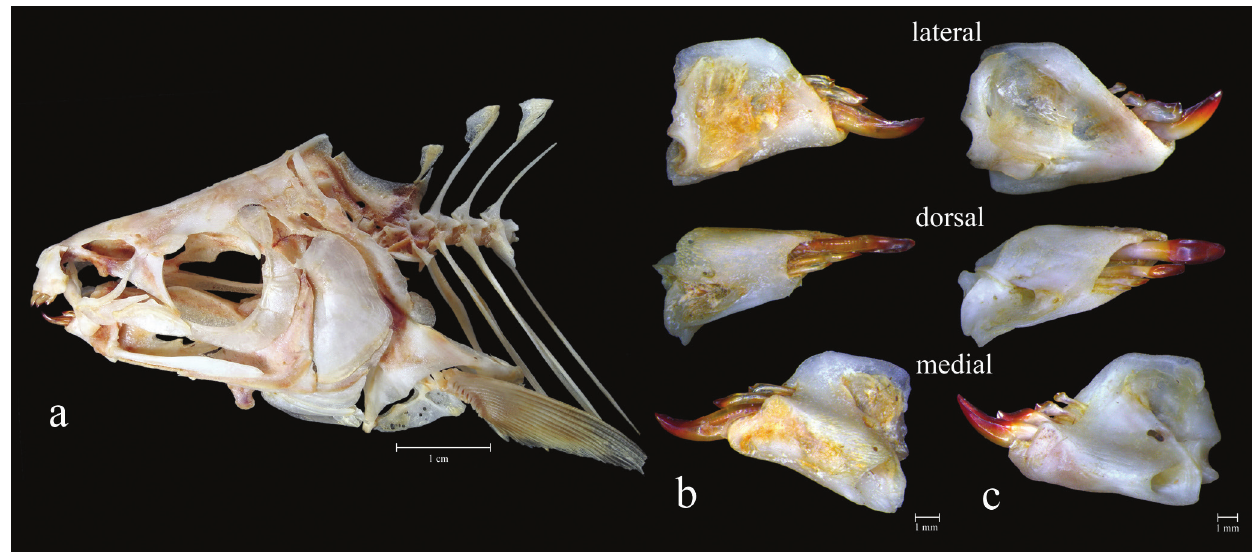
Fig. 1. (a) Head in lateral view and (b) lower jaw of Leporinus enyae , MZUEL 17001, 169.0 mm SL, río Caura, Orinoco basin in Venezuela, (c) lower jaw of L. fasciatus , MZUEL 14698, 221.5 mm SL, rio Negro in Brazil. All specimens dried